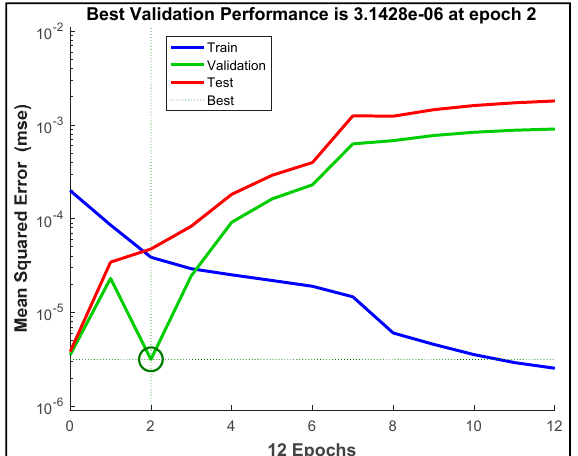
Figure 10. Best validation performance (for sample X).